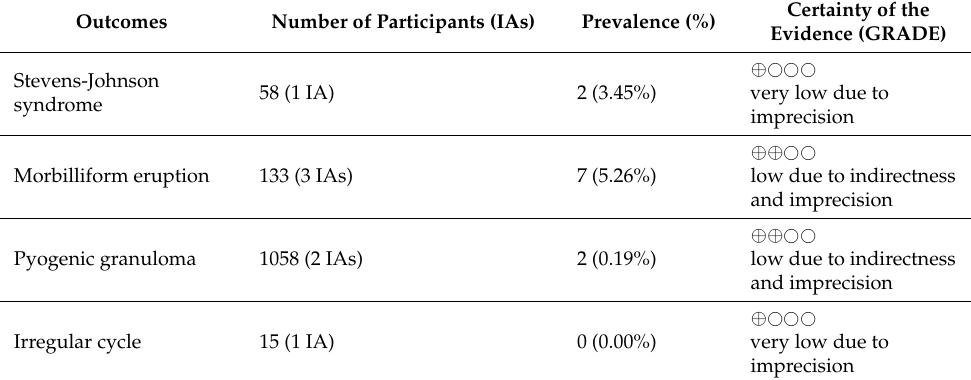
Table 11. Summary of ISO therapy adverse events: other.